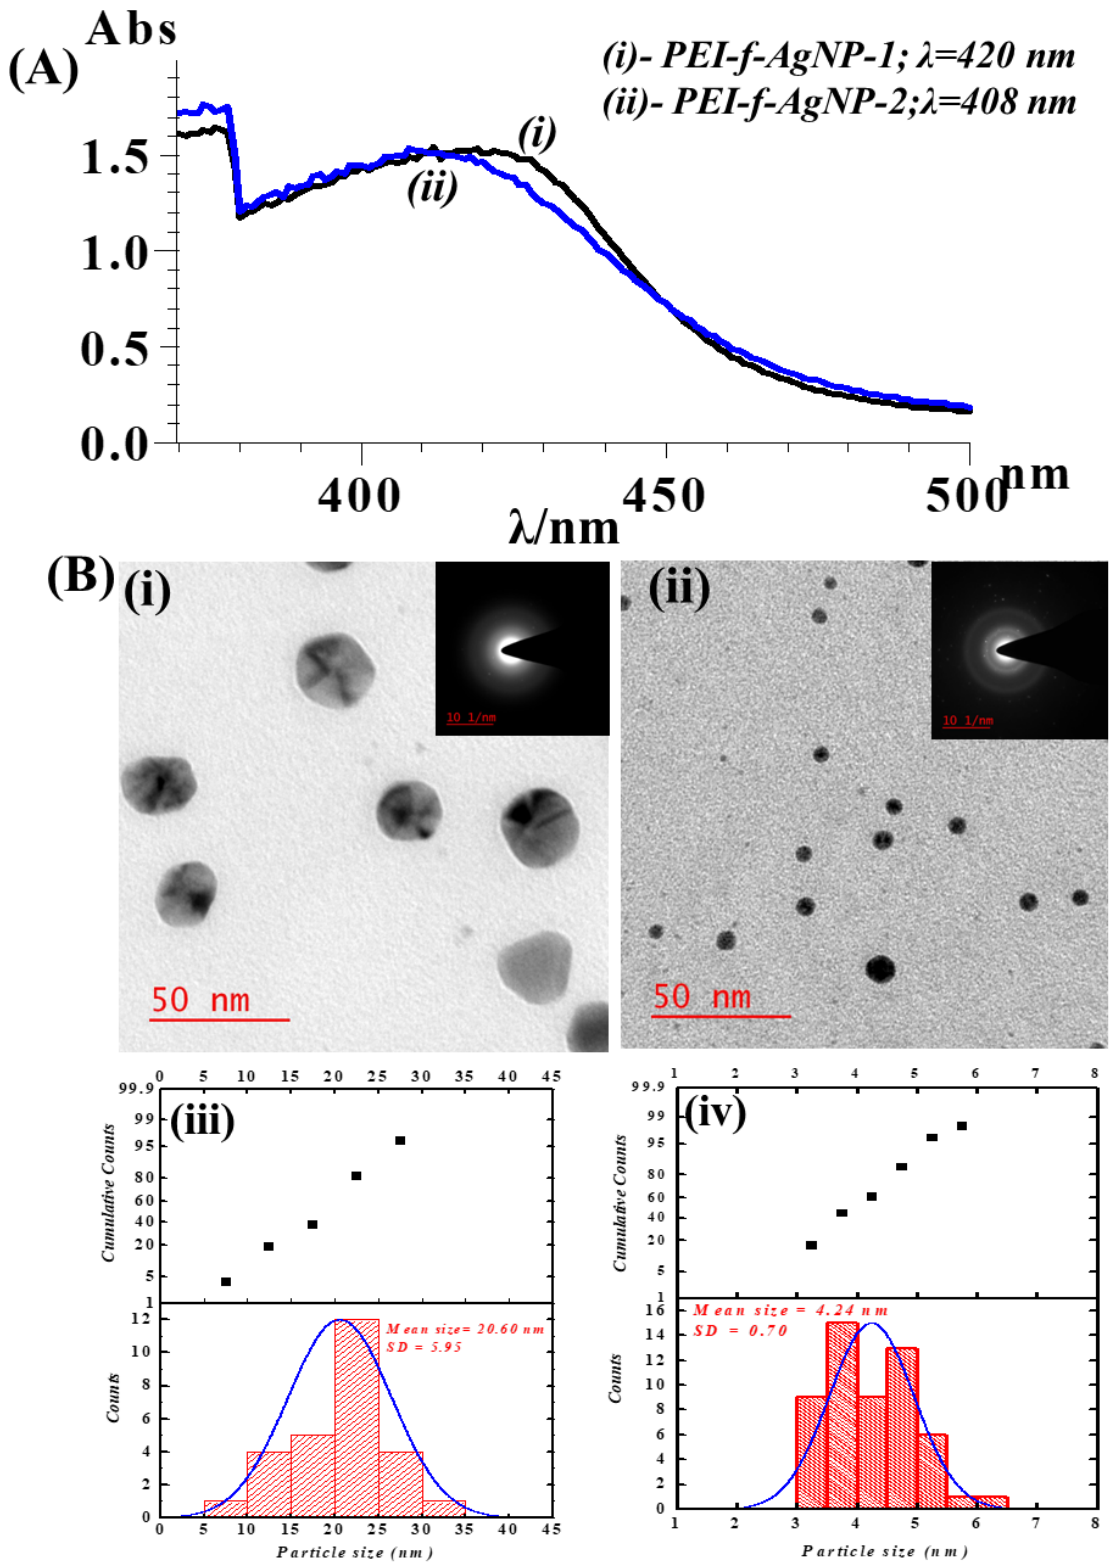
Figure 1. Physical characterization of PEI-f-Ag-NPs. ( A ) UV-Vis spectra of PEI-f-AgNP-1 ( i ) showing an absorption maximum at λ = 420 nm and PEI-f-AgNP-2 ( ii ) showing an absorption maximum at showing at λ = 408 nm. ( B ) shows the TEM image and size histogram of PEI-f-AgNP-1 ( i,iii ) as well as the TEM image and size histogram of PEI-f-AgNP-2 ( ii,iv ).